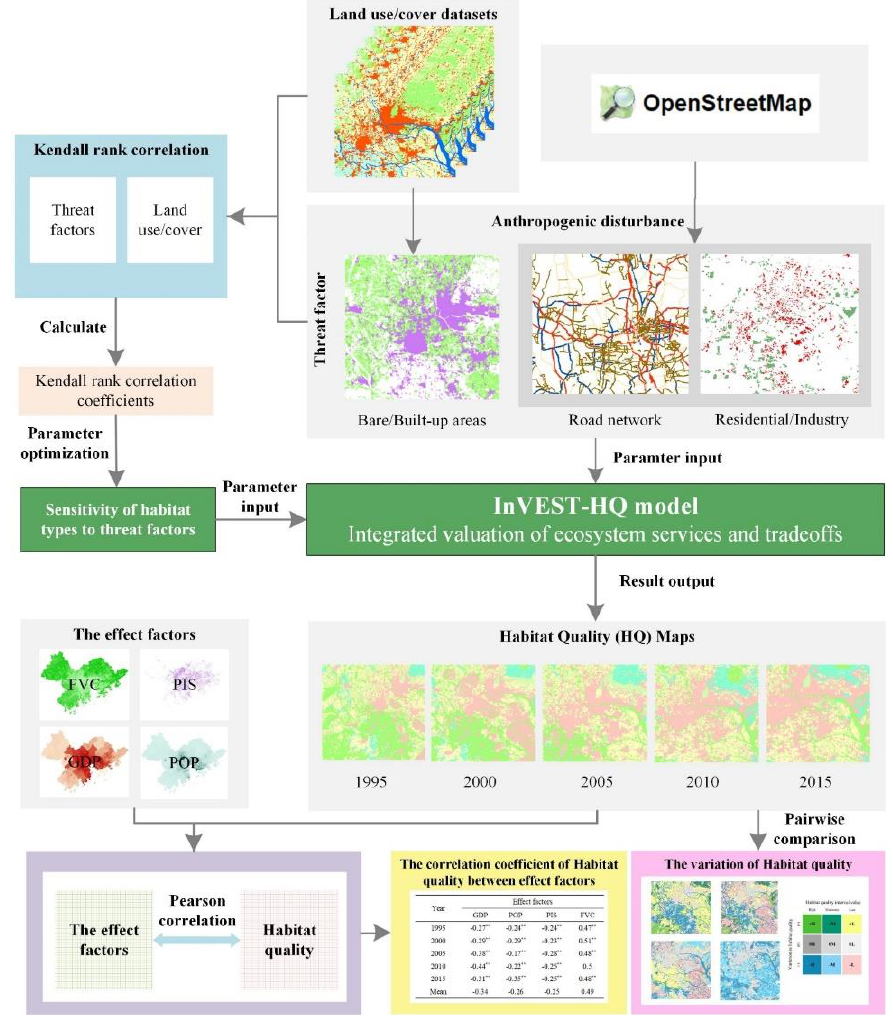
Figure 4. Input data and processing steps to evaluate habitat quality in the Guangdong – Hong Kong – Macao Greater Bay Area (GBA). GDP — gross domestic product; POP — population distribution; PIS — proportion of impervious surface; FVC — fractional vegetation cover.